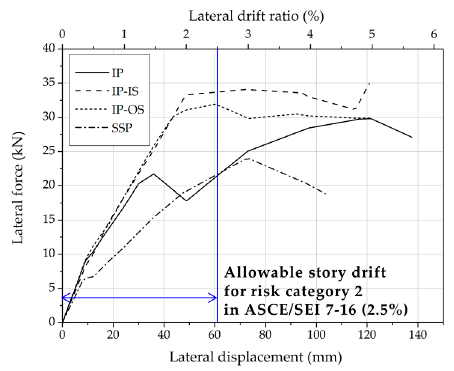
Figure 9. Comparison of the average envelope curves of the specimens.